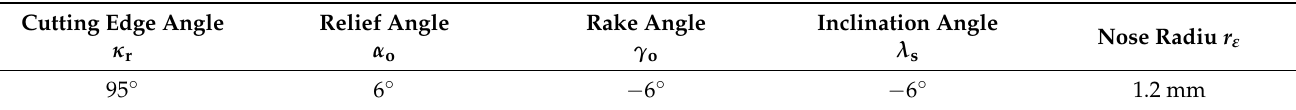
Table 2. Tool geometric